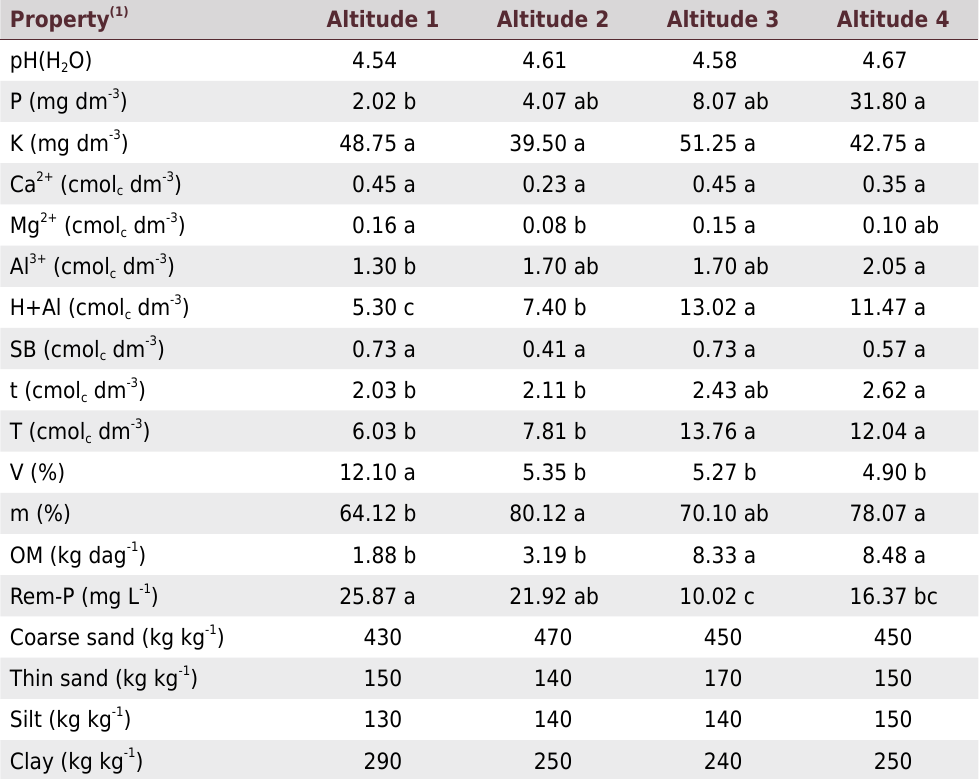
Table 2. Mean values of the chemical and physical properties of the soils at four altitudes in the PARNASO, Rio de Janeiro, Brazil Property